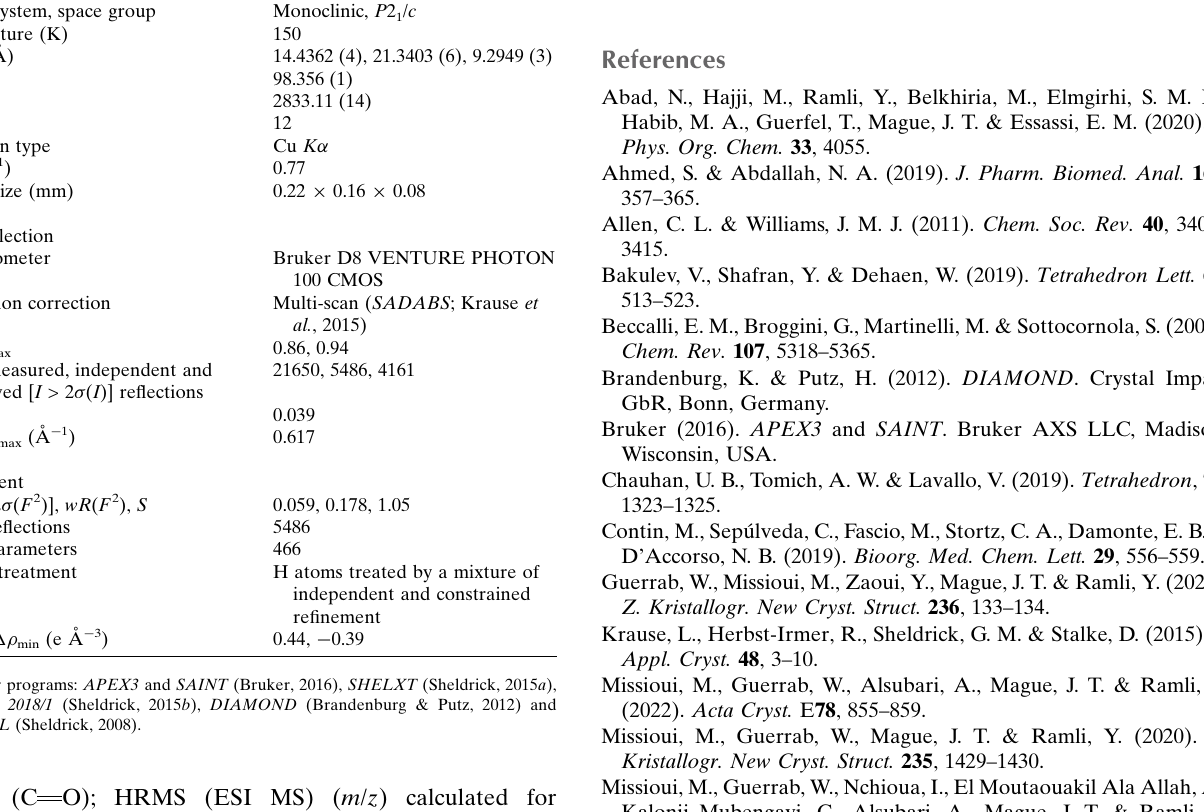
Table 3 Experimental details. Crystal data Chemical